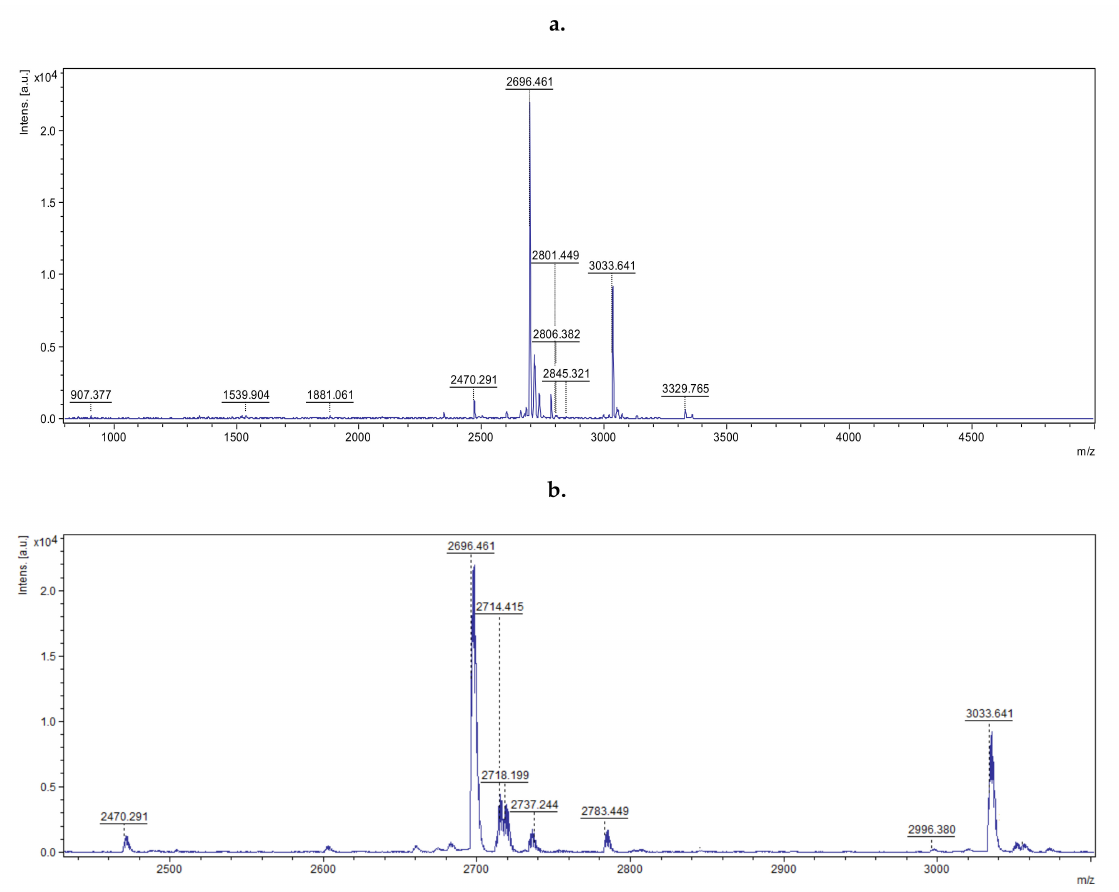
Figure 2. MALDI-TOF spectrum of sample peptide mixture ( a ), extension of range showing ions for MS / MS fragmentation ( b